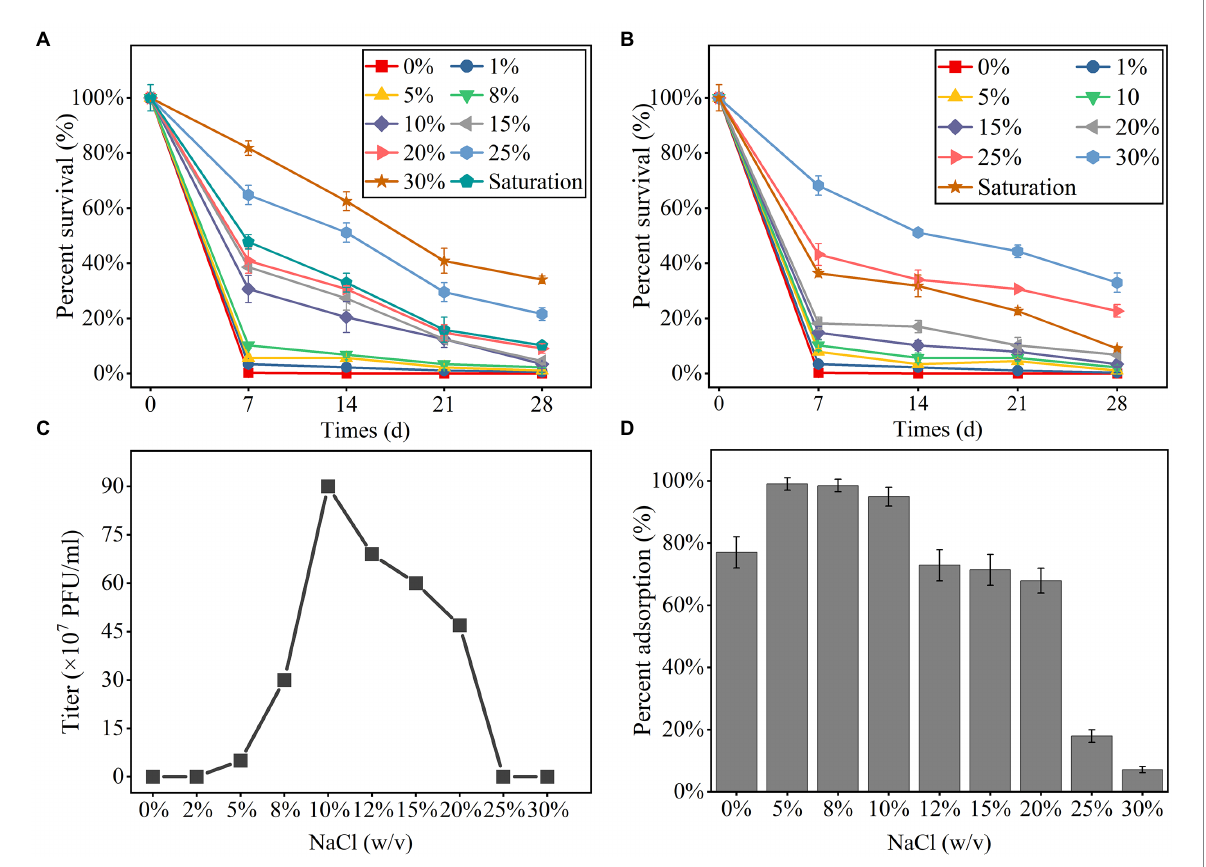
FIGURE 2 The percent survival of YPCBV-1 at different NaCl (A) and KCl (B) concentrations. The range of NaCl concentrations for YPCBV-1 proliferation (C) and the percent adsorption at different NaCl concentrations (D) . Error bars represent the standard deviation of three replicates. (C) has only one